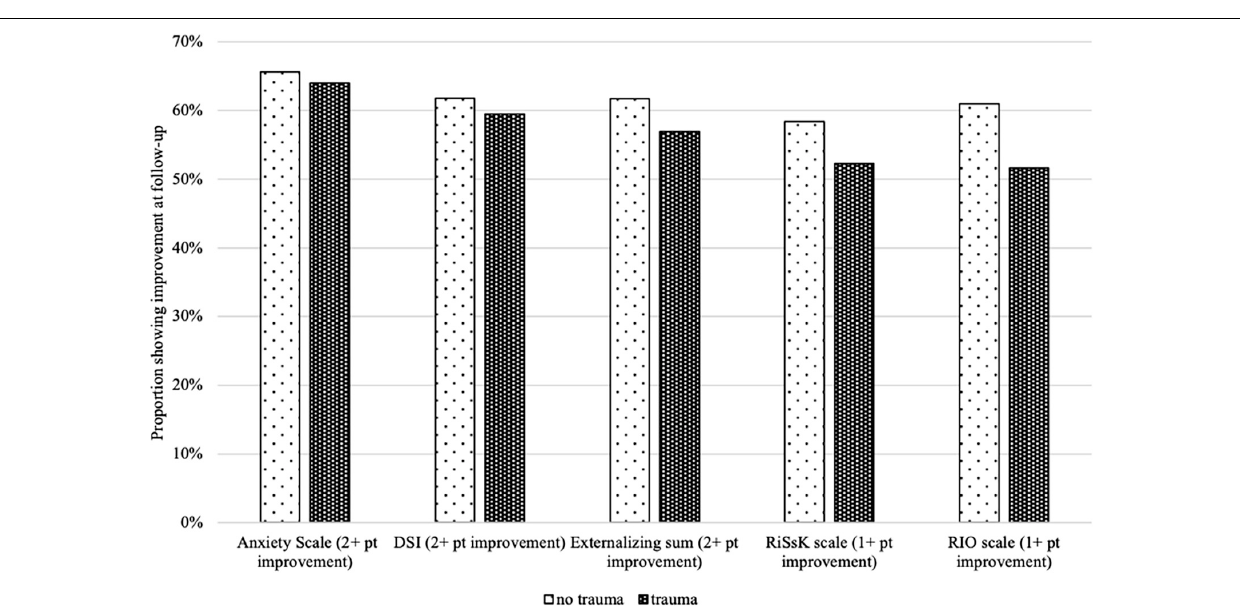
FIGURE 4 | Change from initial to follow-up assessment, by scale and